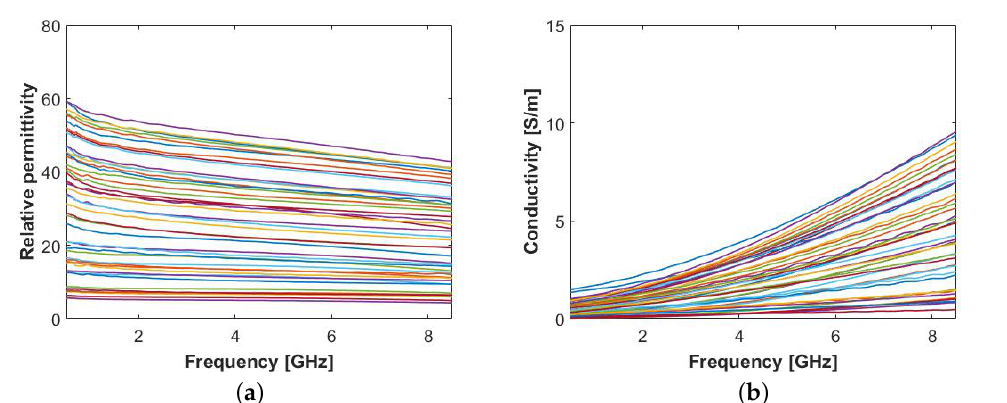
Figure 2. Permittivity results obtained from 11 human axillary lymph node samples measured from the surface layer: ( a ) Relative permittivity, (cid:101) (cid:48) , and ( b ) conductivity, σ